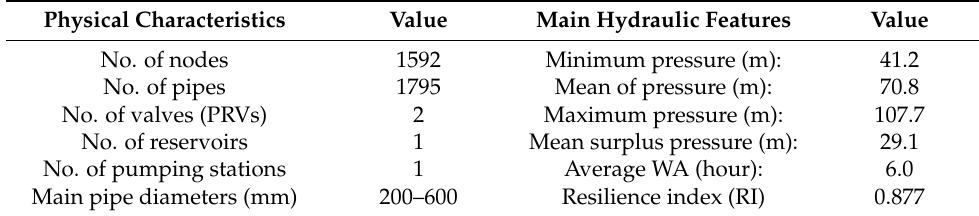
Figure 8. Formation of DMAs in the Wolf-Cordera Ranch water distribution network through the proposed method: ( a ) the original WDN, ( b ) the U-matrix with nodal hits labeled in each cluster, ( c ) SOM initial clusters abstracted to the WDN, and ( d ) modularity indexes for the corresponding number of DMAs following the application of CSA. Table 3. Main characteristics of the Wolf-Cordera Ranch water distribution